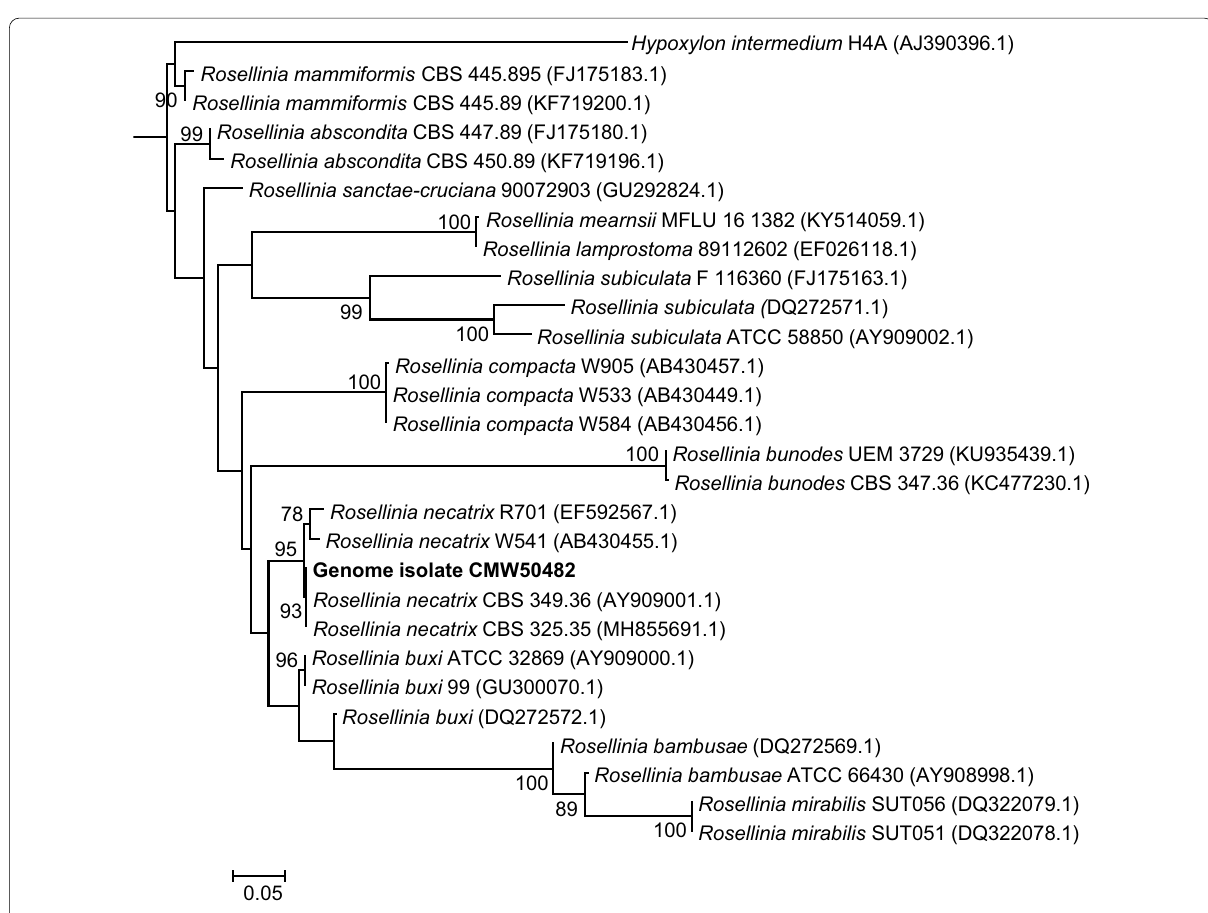
Fig. 8 Identity confirmation of the Rosellinia necatrix isolate sequenced in this study (indicated in bold type). The maximum likelihood phylogeny was constructed from the ITS region using IQ‑TREE v.2 (Minh et al. 2020). Bootstrap values larger than 75 are indicated at nodes. GenBank accession numbers are presented in the